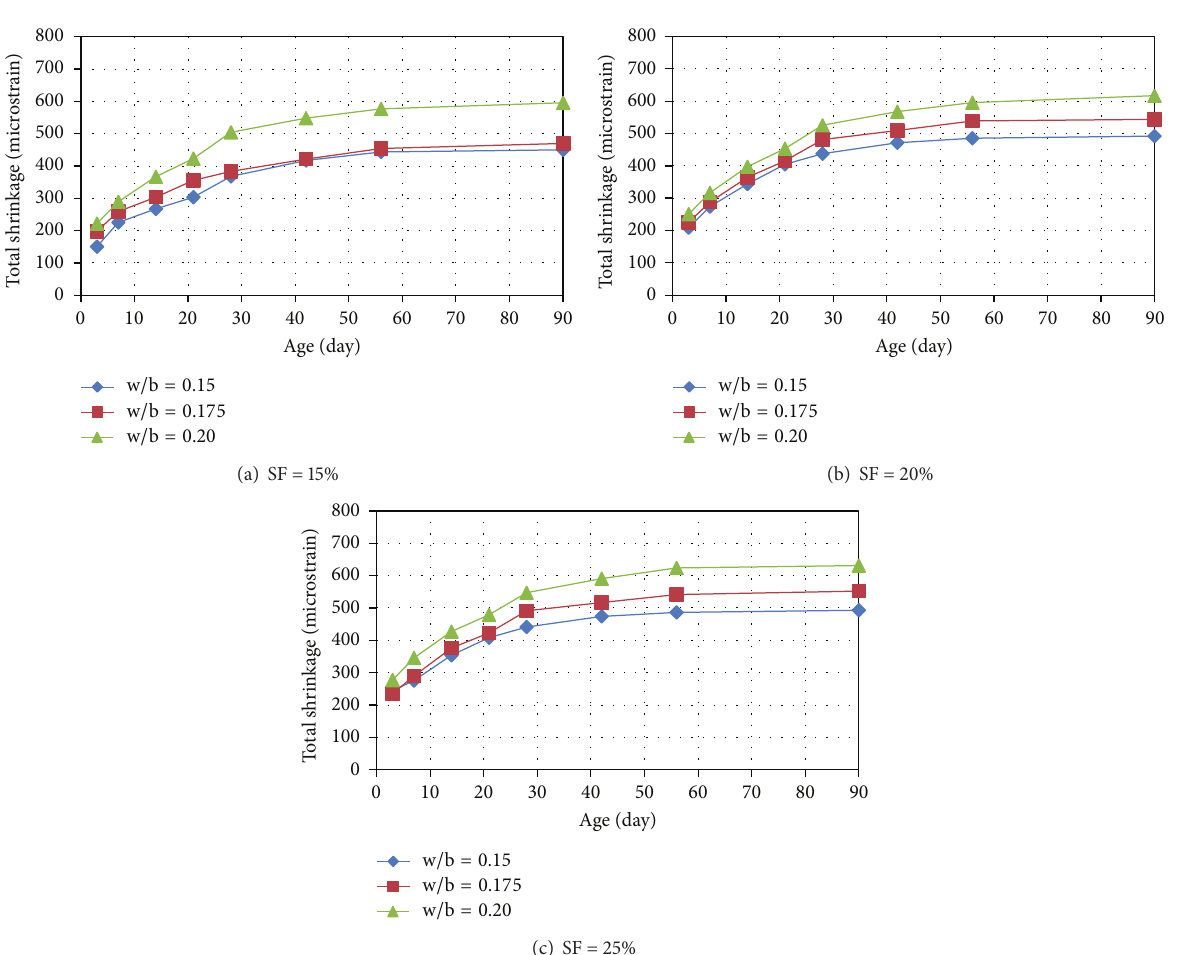
Figure 2: Variation of total shrinkage of RPC mixtures (having cement content of 1000kg/m 3 ) with age.